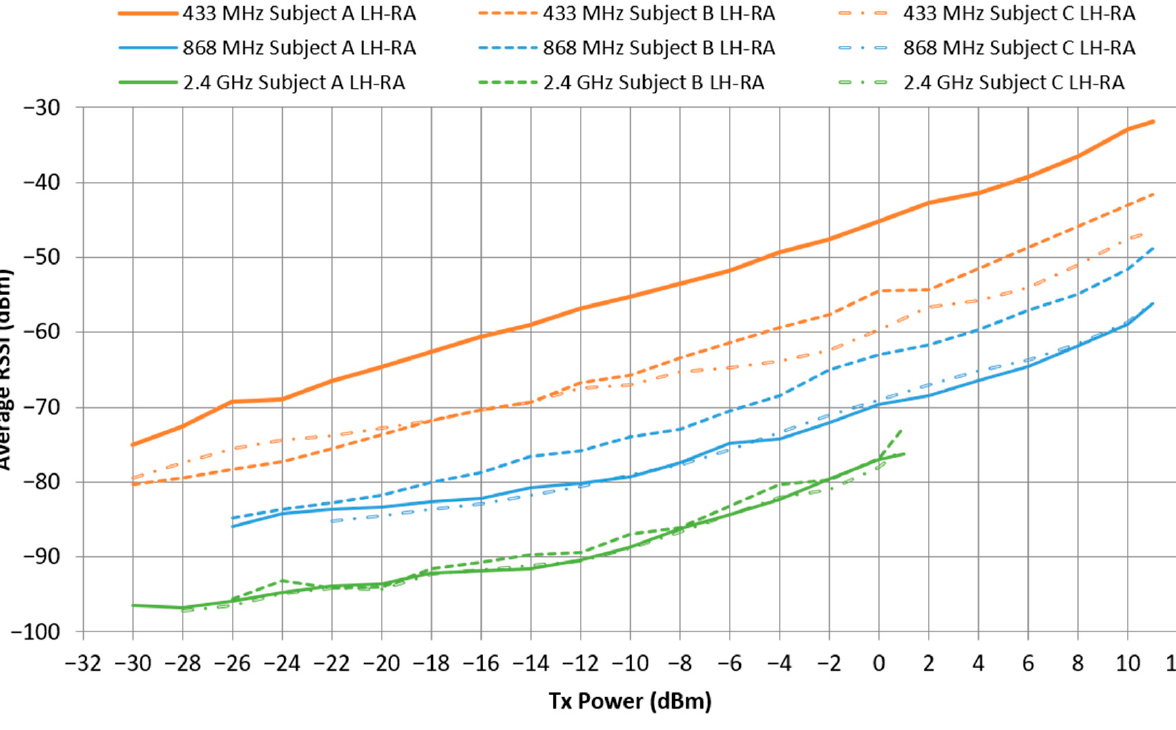
subjects’ wrist, and with a transmit power of − 2 dBm. It is clear that the different walking patterns—especially the arm swing—of the three people produce a distinct periodic peak shape in the RSSI curve. For instance, it can be inferred that Subject A swings her arm